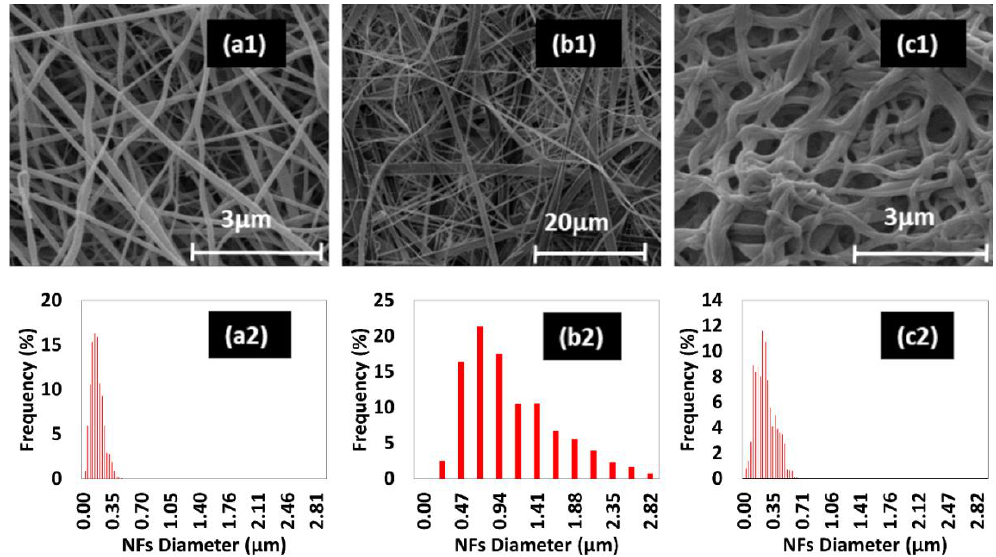
Figure 1. SEM images (number 1) and diameter distribution of NFs (number 2) for samples after post-treatment: ( a ) KSFA, ( b ) KSHFIP, ( c ) KSPEO-180 °C and 24 h in water.